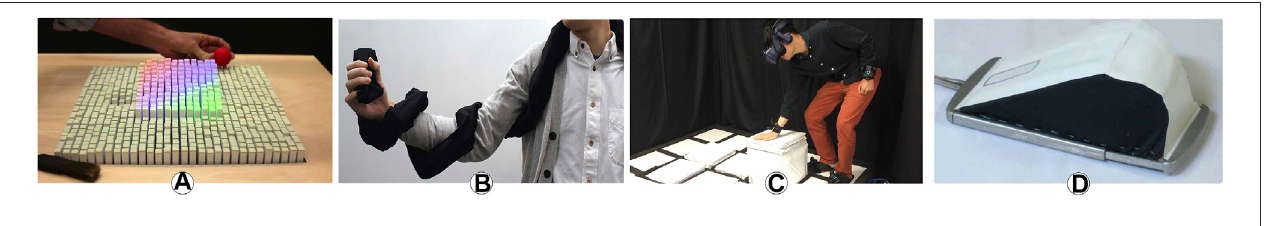
FIGURE 2 | Examples of various ways shape-changing interfaces researchers and designers have proposed to augment human-computer interaction: (A) dynamically actuated shape displays such as Materiable (Nakagaki et al., 2016b), (B) deformable, actuated linkages such as LineFORM (Nakagaki et al., 2015), (C) in fl atable structures such as TilePoP (Teng et al., 2019), and (D) In fl atable Mouse: a volume-adjustable mouse with air-pressure-sensitive input (Kim et al., 2008).